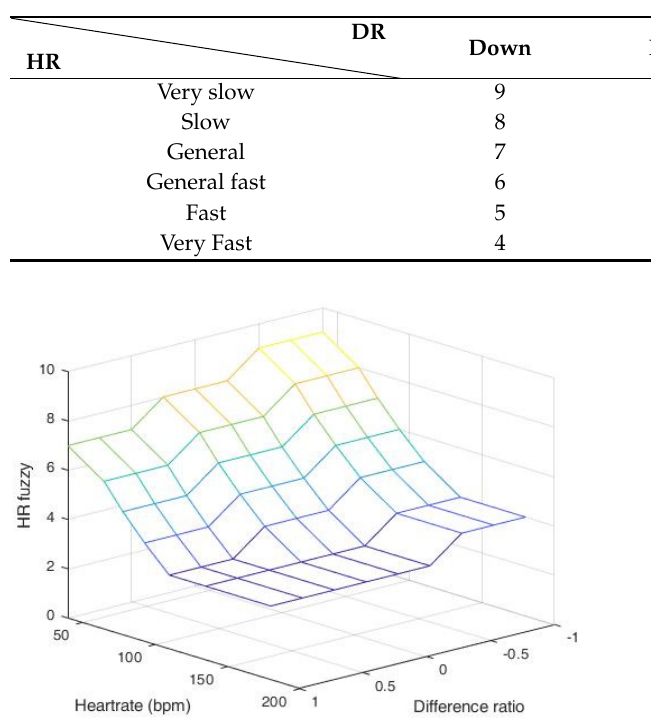
Table 4. A fuzzy rule-based model.